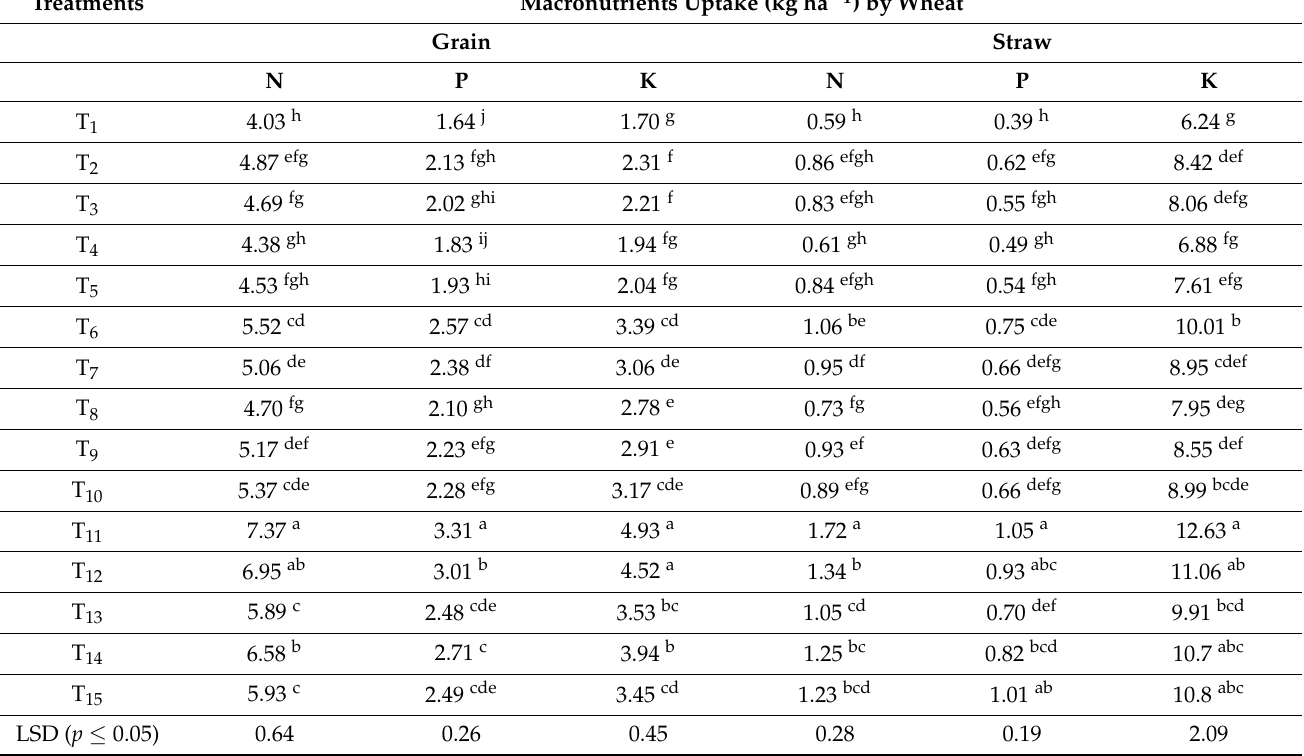
Table 4. Effect of different fertilizers and manures on N, P and K macronutrients uptake in grain and straw of